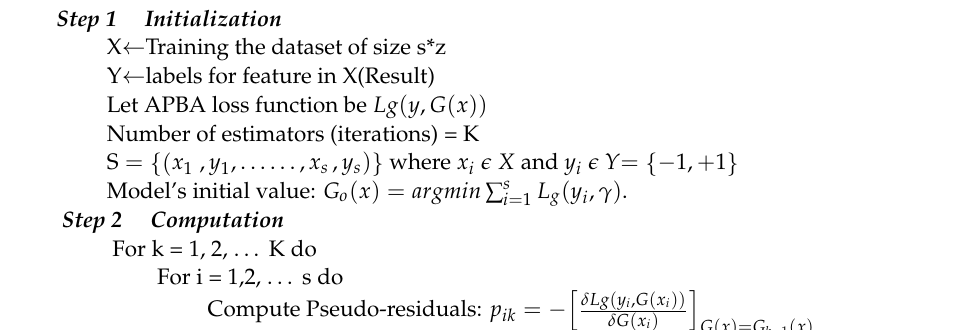
Algorithm 2: Anti Phishing Boosting Algorithm (APBA)